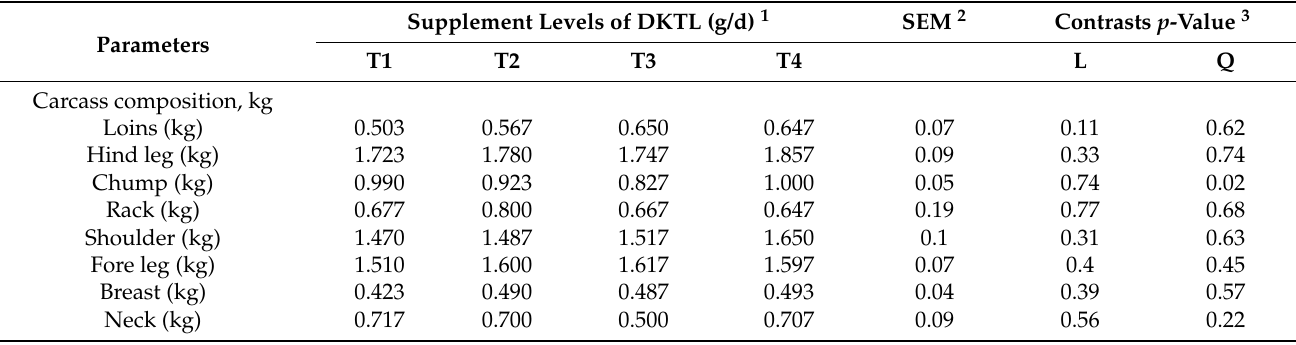
Table 5. Effects of Kratom leaves supplement on carcass composition of fattening